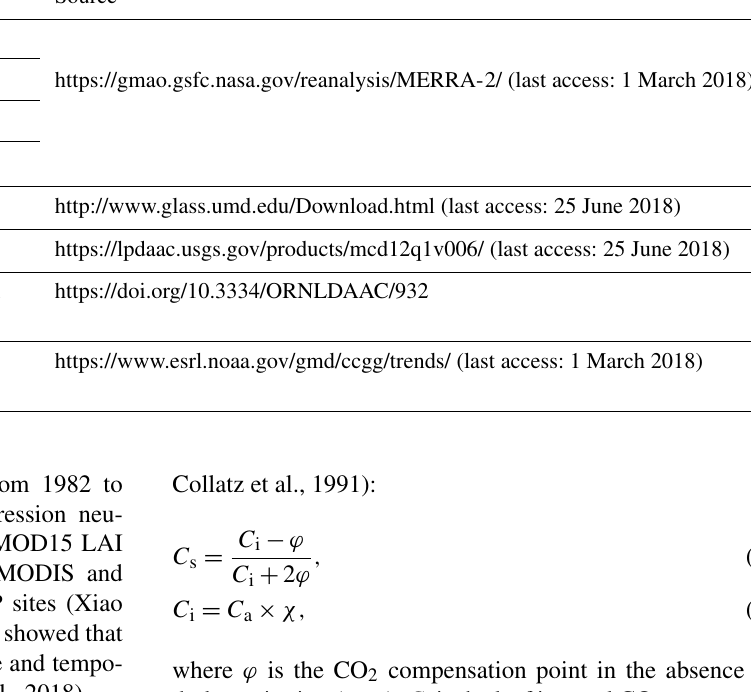
Table 2. Input datasets used to drive the revised EC-LUE model.